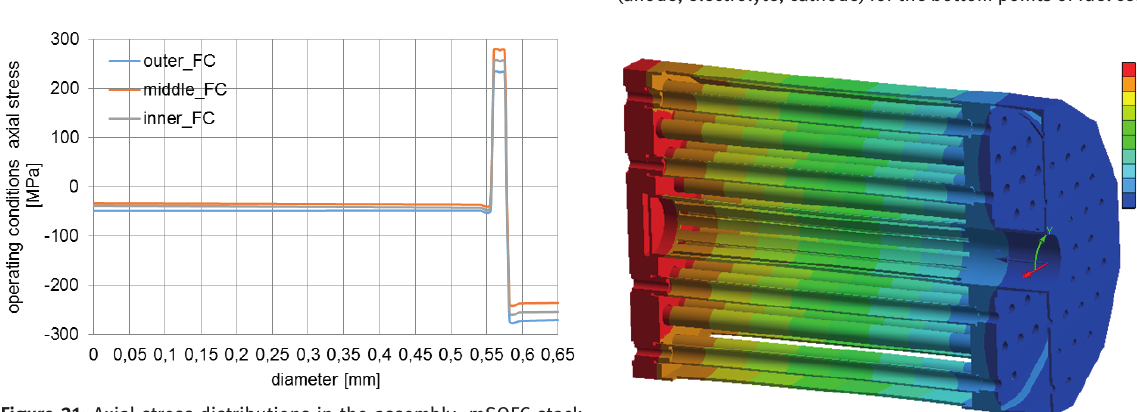
Figure 21: Axial stress distributions in the assembly: mSOFC stack, sealants, manifolds along the vertical centerlines of each layer (anode, electrolyte, cathode) for the bottom points of fuel cell.